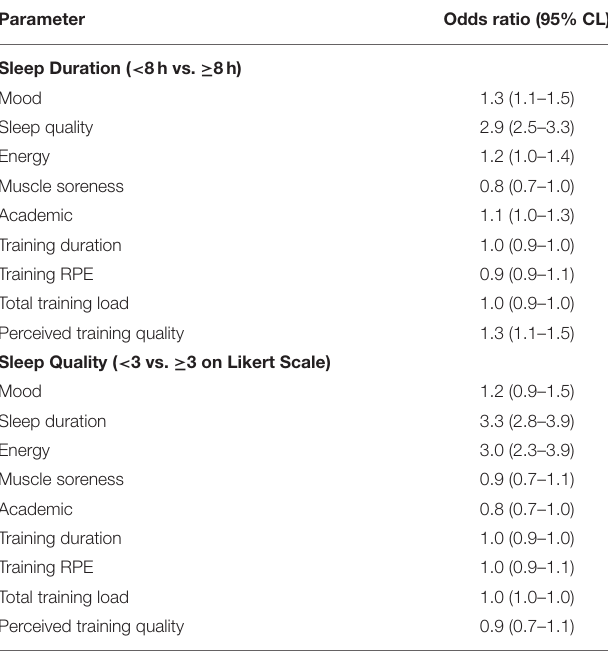
TABLE 4 | Association between sleep characteristics and athlete’s subjective and training parameters.